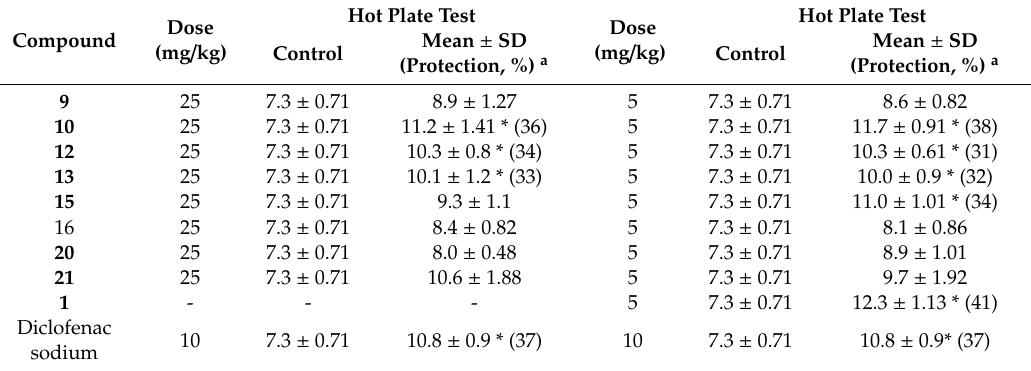
Table 3. Analgesic activity of compounds 1 , 9 , 10 , 12 , 13 , 15 , 16 , 20 , 21 and Diclofenac